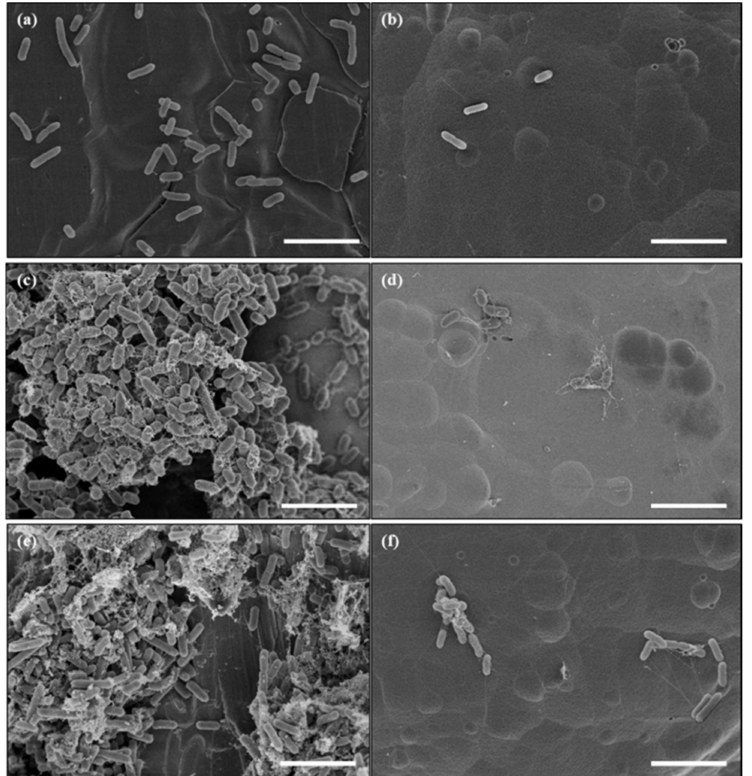
Figure 7. Comparison of bacterial attachment and biofilm formation of E. coli O157:H7 on bare stainless steel ( a , c , e ) and nanoengineered stainless steel (stainless steel electrochemically etched at 10 V for 10 min with Teflon coating) ( b , d , f ) observed by FE-SEM. Bacteria were attached on the surfaces after being submerged in bacterial cell suspension for 4 h ( a , b ), under static ( c , d ) and flow conditions ( e , f ). White scale bars in ( a – f ) indicate 5 µ